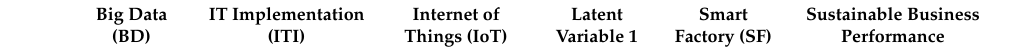
Table 3. Factor Loadings.